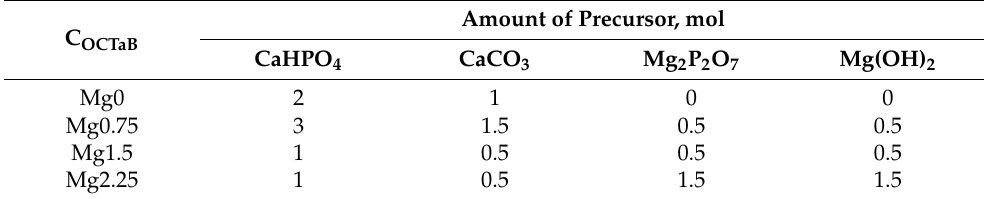
Table 1. Precursor ratios for Mg x Ca (3 − x) (PO 4 ) 2